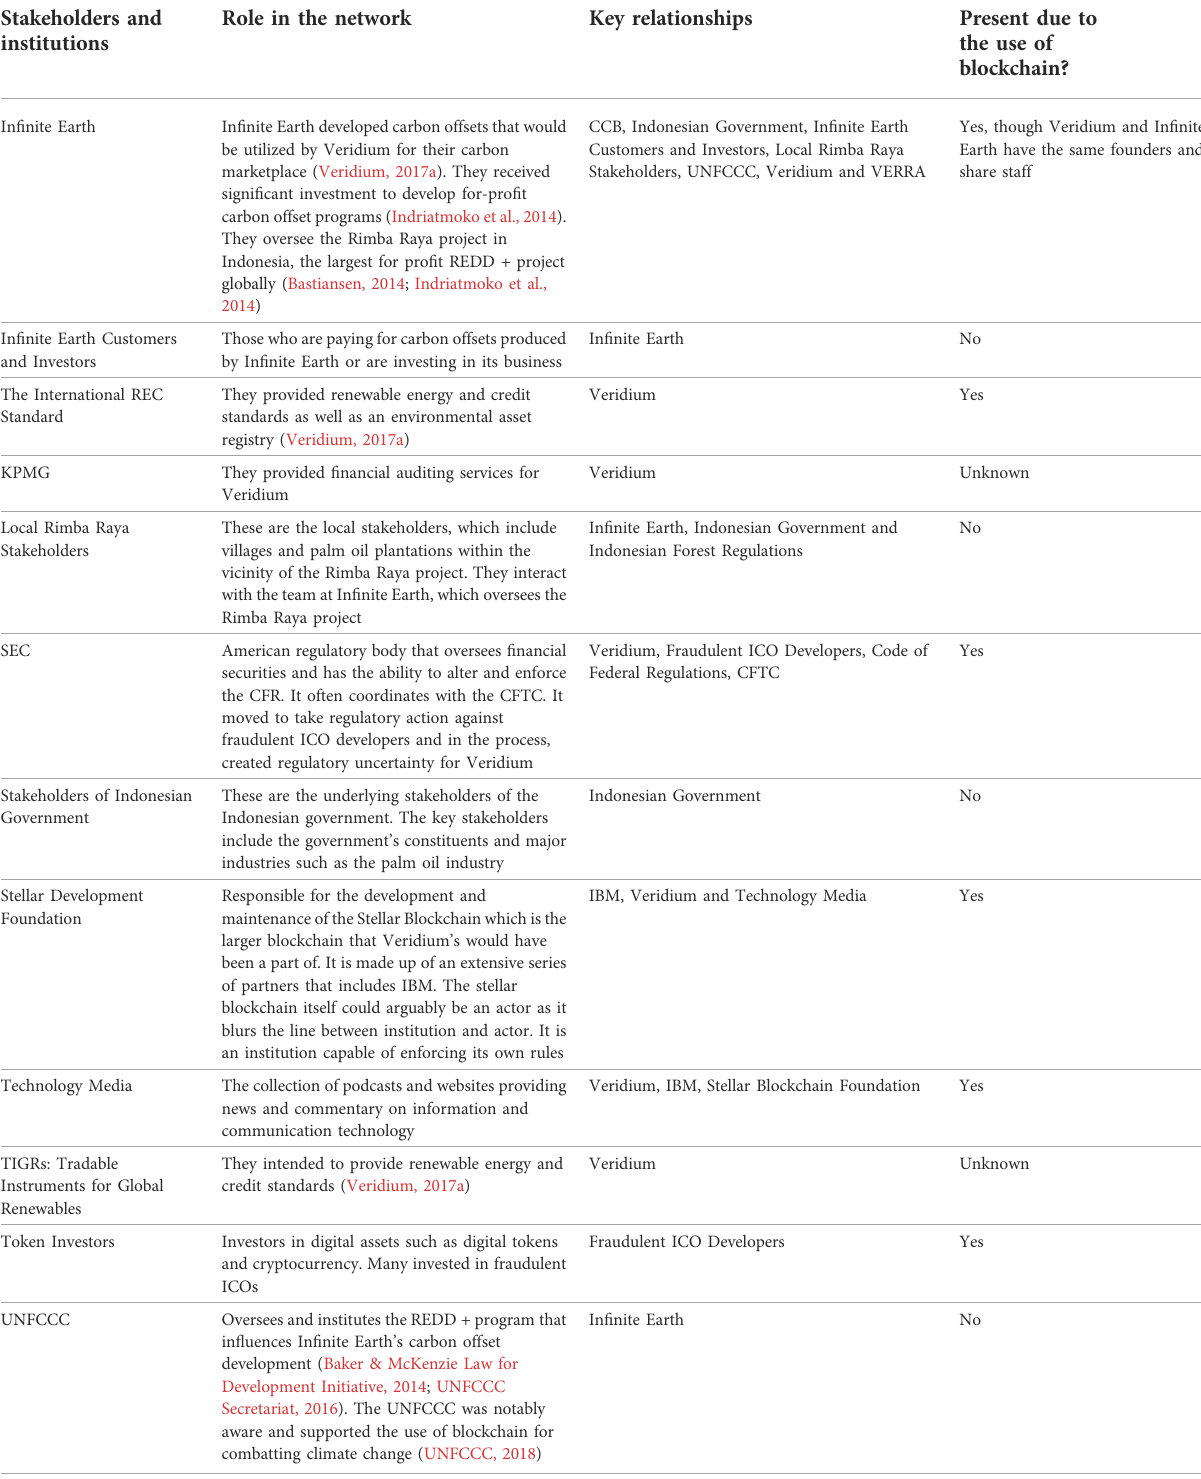
TABLE 2 ( Continued ) List of stakeholders, role within the network, and their key relationships. Several are listed as partners in early documents. However, it is unclear if they were still involved at the time of data collection.